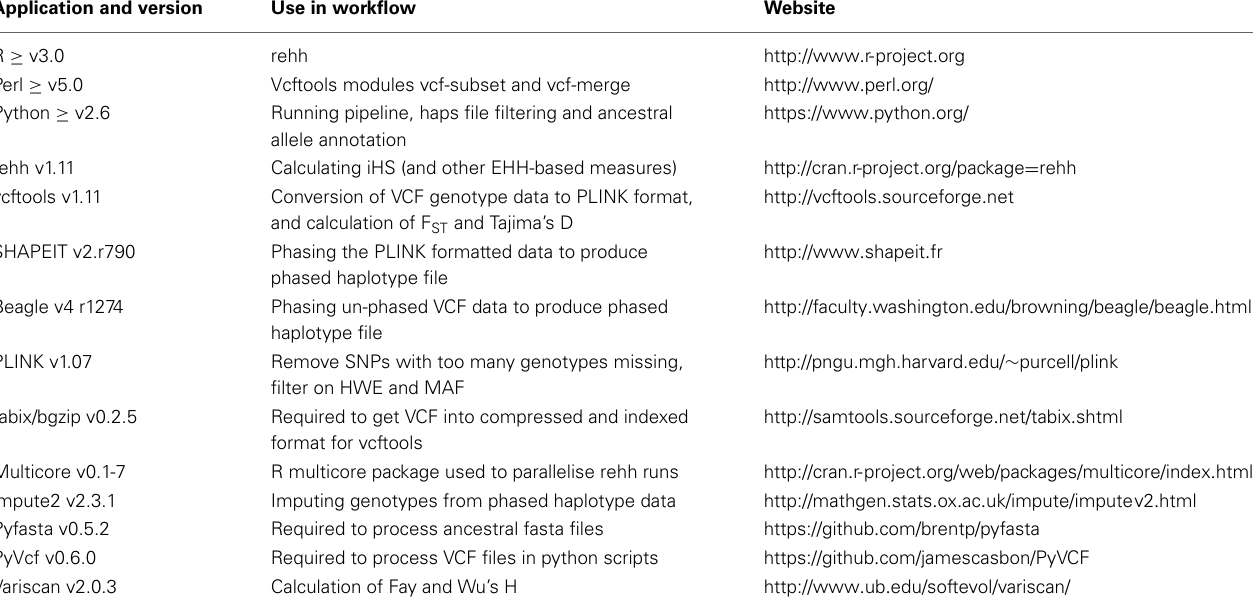
Table 1 | Software tools used in the selection analysis